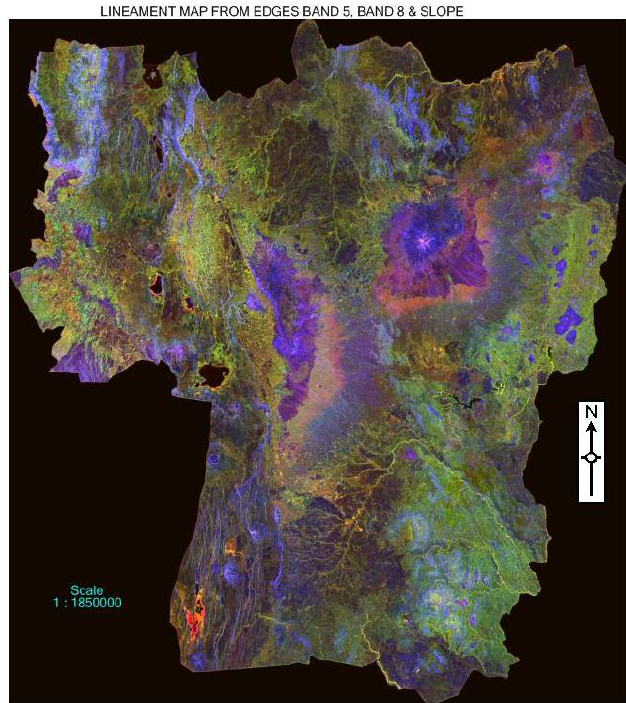
Figure 9: RGB with edges from band ratio 5/1, Band 8 &